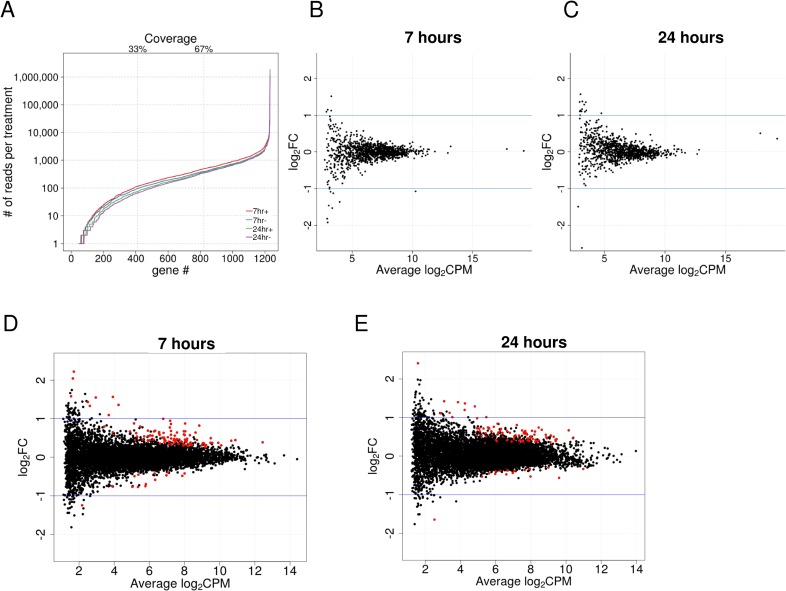
Analysis of changes in Wolbachia and D. melanogaster gene expression upon viral infection.Jw18Wol cells infected with SFV4(3H)-RLuc were analyzed. (A) Sequence coverage of Wolbachia genes. Genes are arranged from lowest to highest coverage on the X axis. In the legend + refers to the presence of SFV. (B-C) The response to infection (log2 fold expression change) for each Wolbachia gene is shown against expression level (average log2 count per million [CPM]) at (B) 7 h and (C) 24 h after infection. (D-E) The response to infection of D. melanogaster genes. Genes that significantly change in expression at 10% false discovery rate (FDR) are shown in red (there were no significant induction/repression for Wolbachia genes).